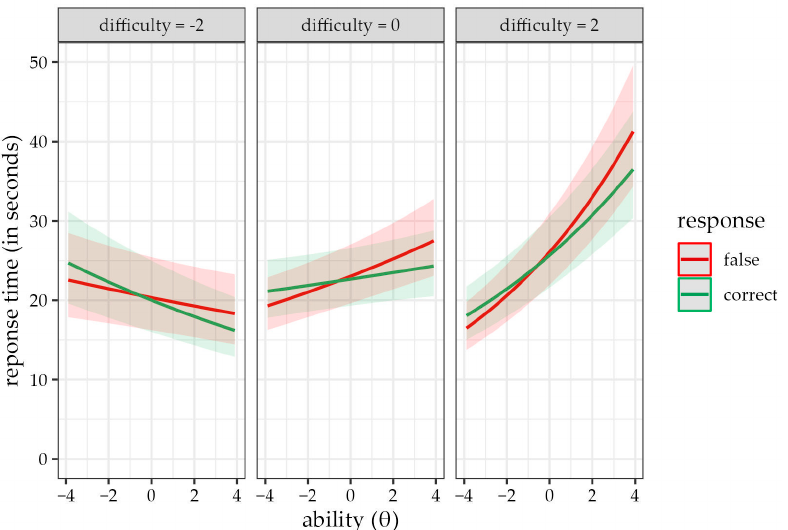
Figure 3. Predicted response time values according to the exploratory model A3 for correct (green line) and incorrect (red line) responses depending on children’s ability. The graph is divided into three panels based on di ff erent item di ffi culty levels. The observed di ff erence in slopes of correct and incorrect responses is visibly weaker in Model A4. This further expands Model A3, as the proposition that the time required to answer incorrectly answered items (red line) increases with ability level is applicable only for moderately (e.g., di ffi culty = 0) and highly (e.g., di ffi culty = 2) di ffi cult items.